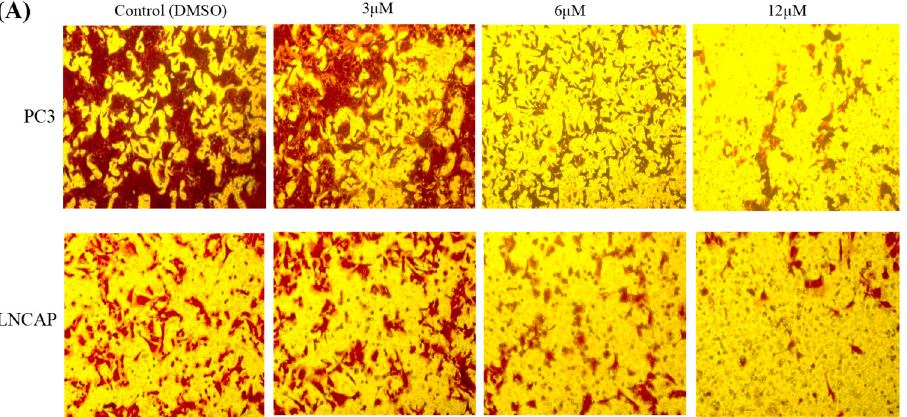
Int. J. Mol. Sci. 2019 , 20 , x FOR PEER REVIEW 9 of 26 Figure 3. Effect of TC7 on cell cycle of PCa and LNCAP cells. Cells were treated with TC7 at different concentrations (3, 6, and 12 μ M) for 24 h. ( A ) Effect of TC7 on the cell cycle of PCa and LNCAP cells by flow cytometry. Cells were fixed and stained with propidium iodide (PI) to analyze the DNA content by flow cytometry. The bar graph shows PC3 and LNCAP cells percentage